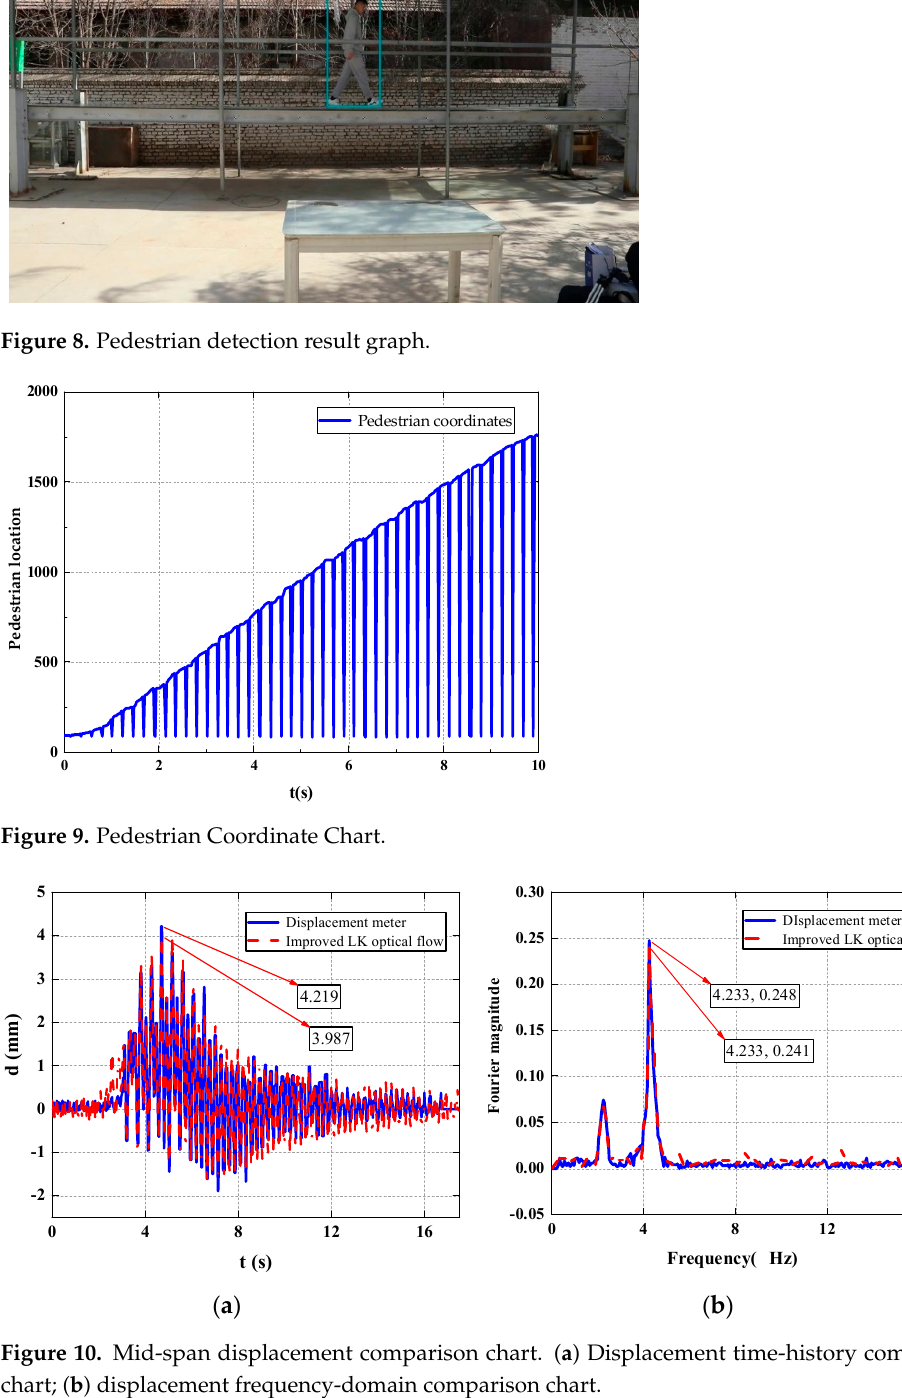
Point 10 Figure 11. Multipoint displacement recognition results.